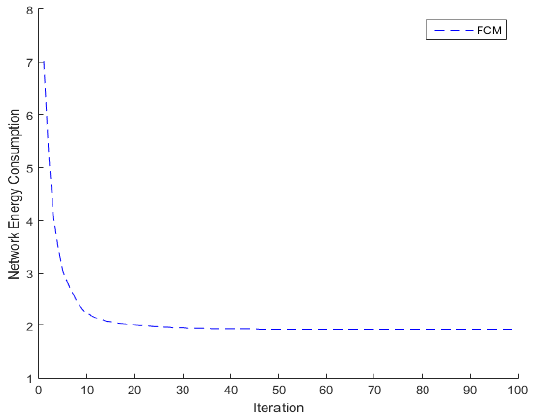
Figure 3. The decrease in the total amount of energy consumed by the network over 100 iterations using the FCM algorithm The result of the Fuzzy Subtractive algorithm is shown in Figure 4. Moreover, the effect of the neighbourhood radius r a on the Fuzzy Subtractive algorithm has been explored. Figure 5 shows the effect of r a on the total energy consumed by sensors.